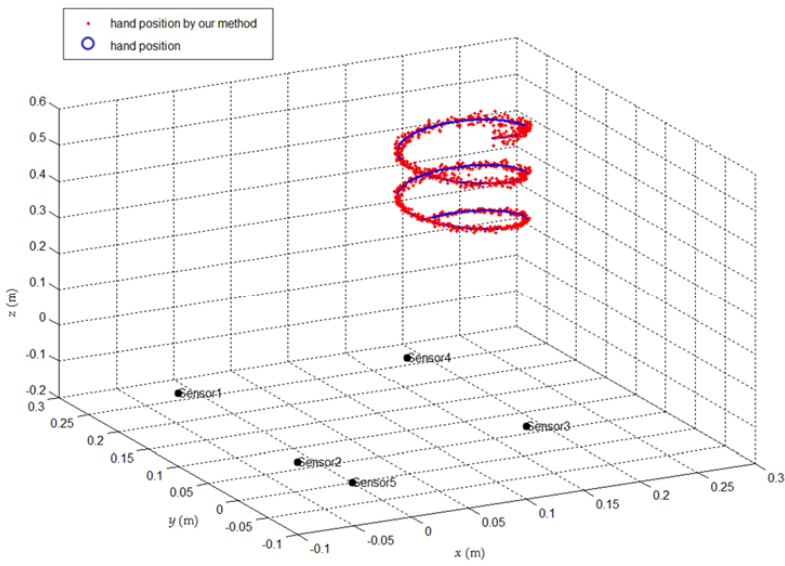
Figure 10. Hand position and trajectory curve obtained by constrained scanning positioning method.